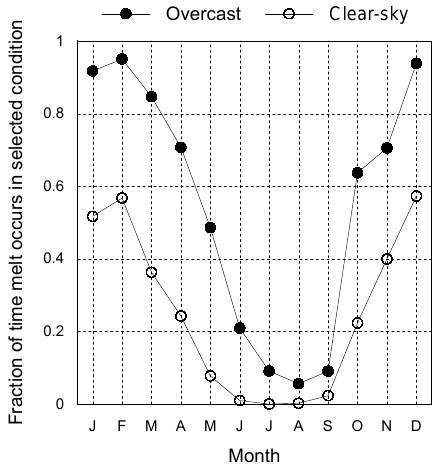
Figure 7. Fraction of time surface melting occurred in clear-sky (open circles) and overcast (closed circles) conditions during each month. Melting conditions are selected as periods where QM >0 in SEBmr.